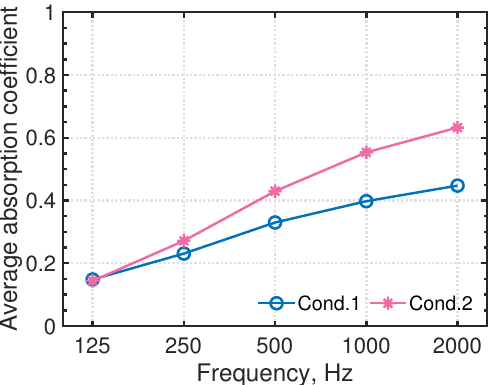
Figure 8. Average absorption coefficients of the auditorium for two absorption